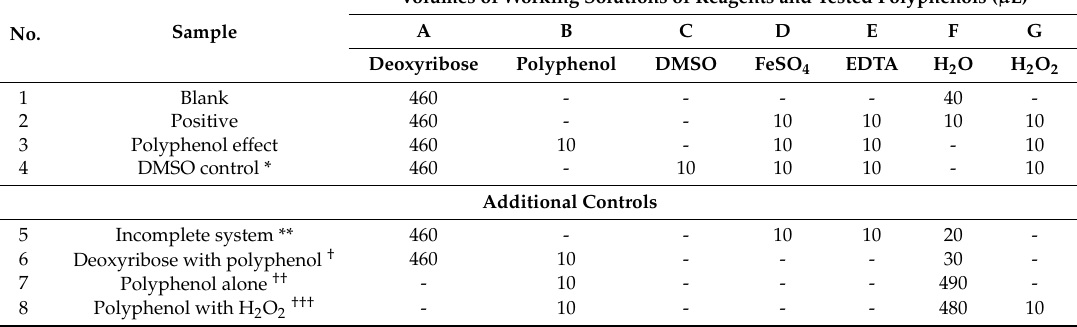
Table 4. Design of experiments on the effect of polyphenols on the oxidative degradation of deoxyribose in the Fenton system (Fe 2+ -EDTA-H 2 O 2